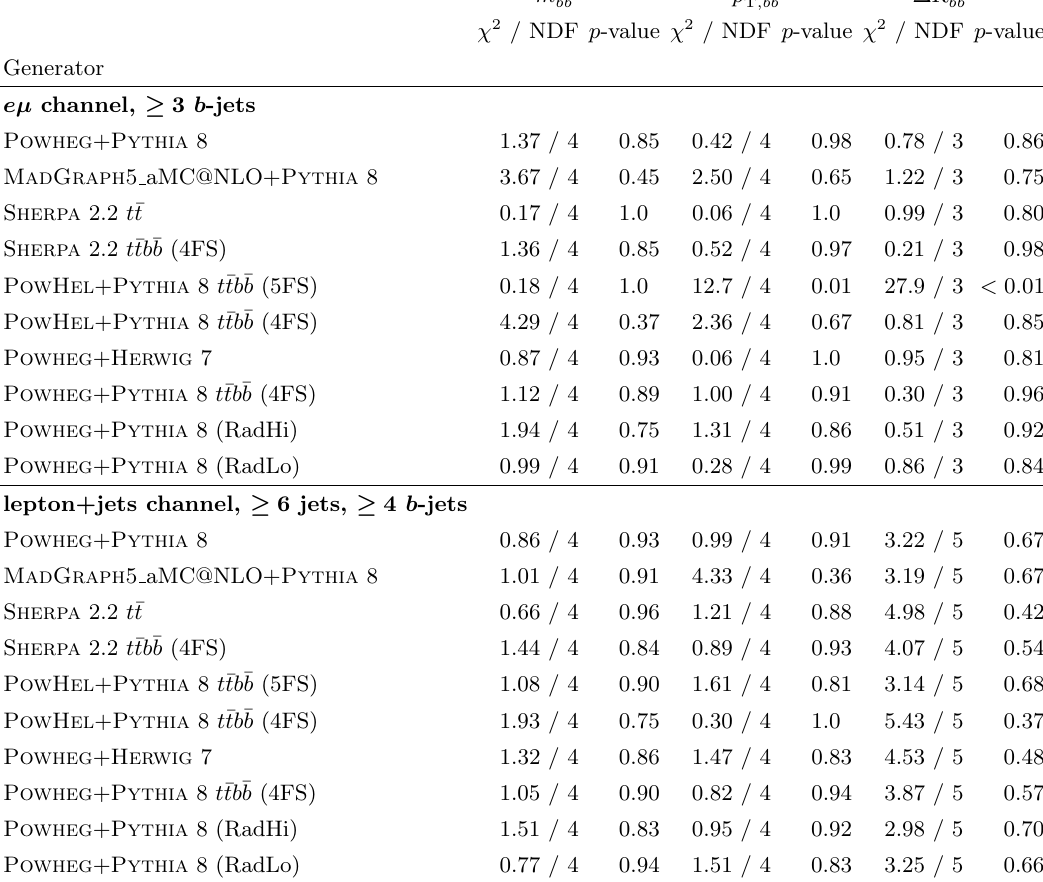
Table 11. Values of (cid:31) 2 per degree of freedom and p -values between the unfolded normalised cross- sections and the various predictions for the mass, p T and (cid:1) R of the closest two b -jets in the e(cid:22) and lepton + jets channels. The number of degrees of freedom is equal to the number of bins in the measured distribution minus